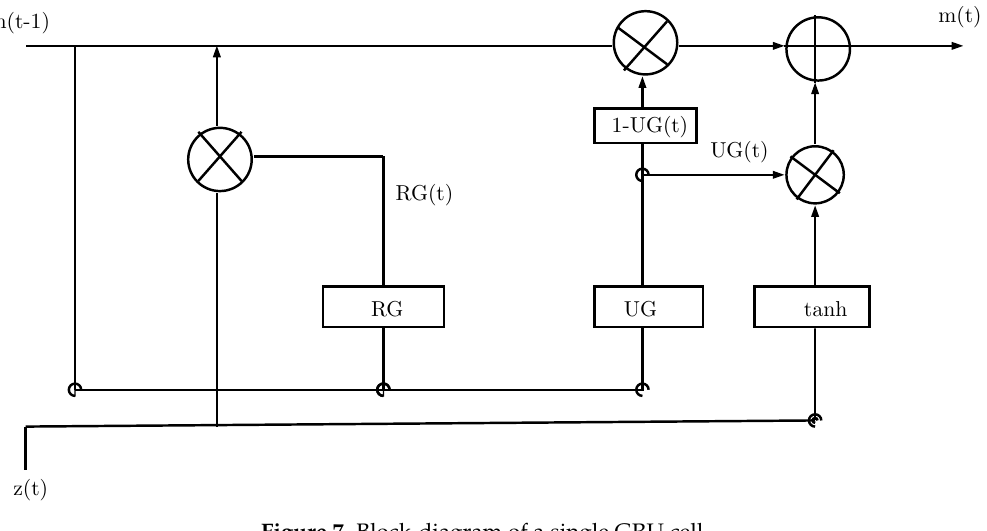
Figure 7. Block-diagram of a single GRU cell. Table 2. Training parameters of LSTM-, BLSTM- and GRU-based classifiers for the automated classification of both BMAC vs. GMAC and BFMAC vs. DMAC